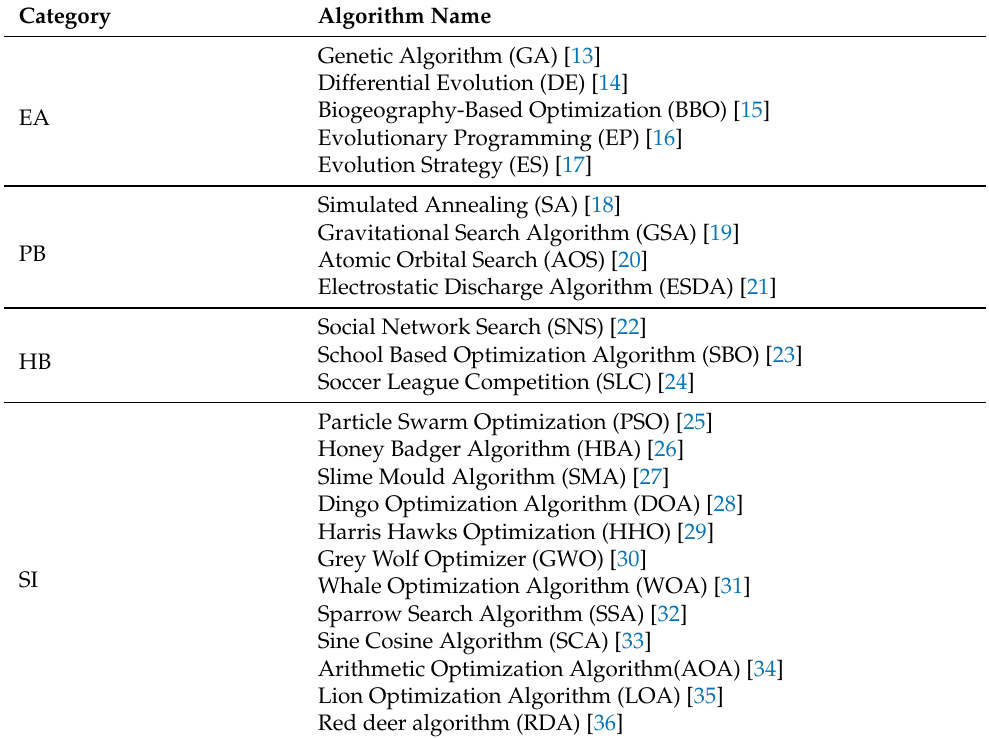
Table 1. Categories of MH